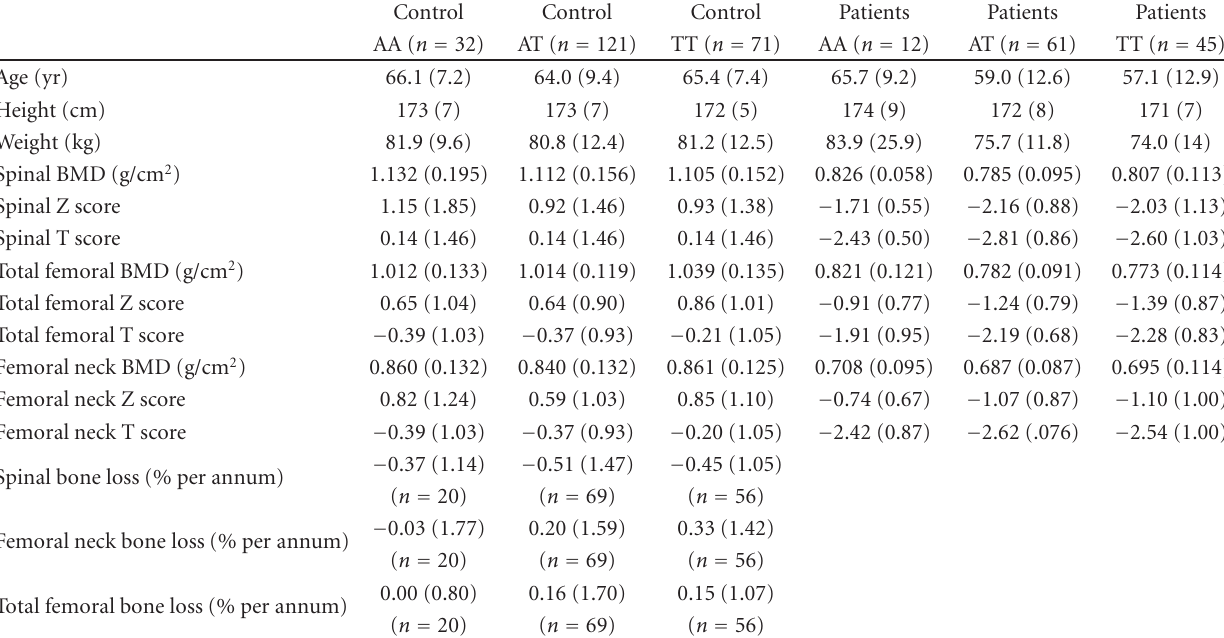
Table 4: BMP2 SNP3 genotypes and age, weight, height, BMD and annualised bone loss in male controls and men with